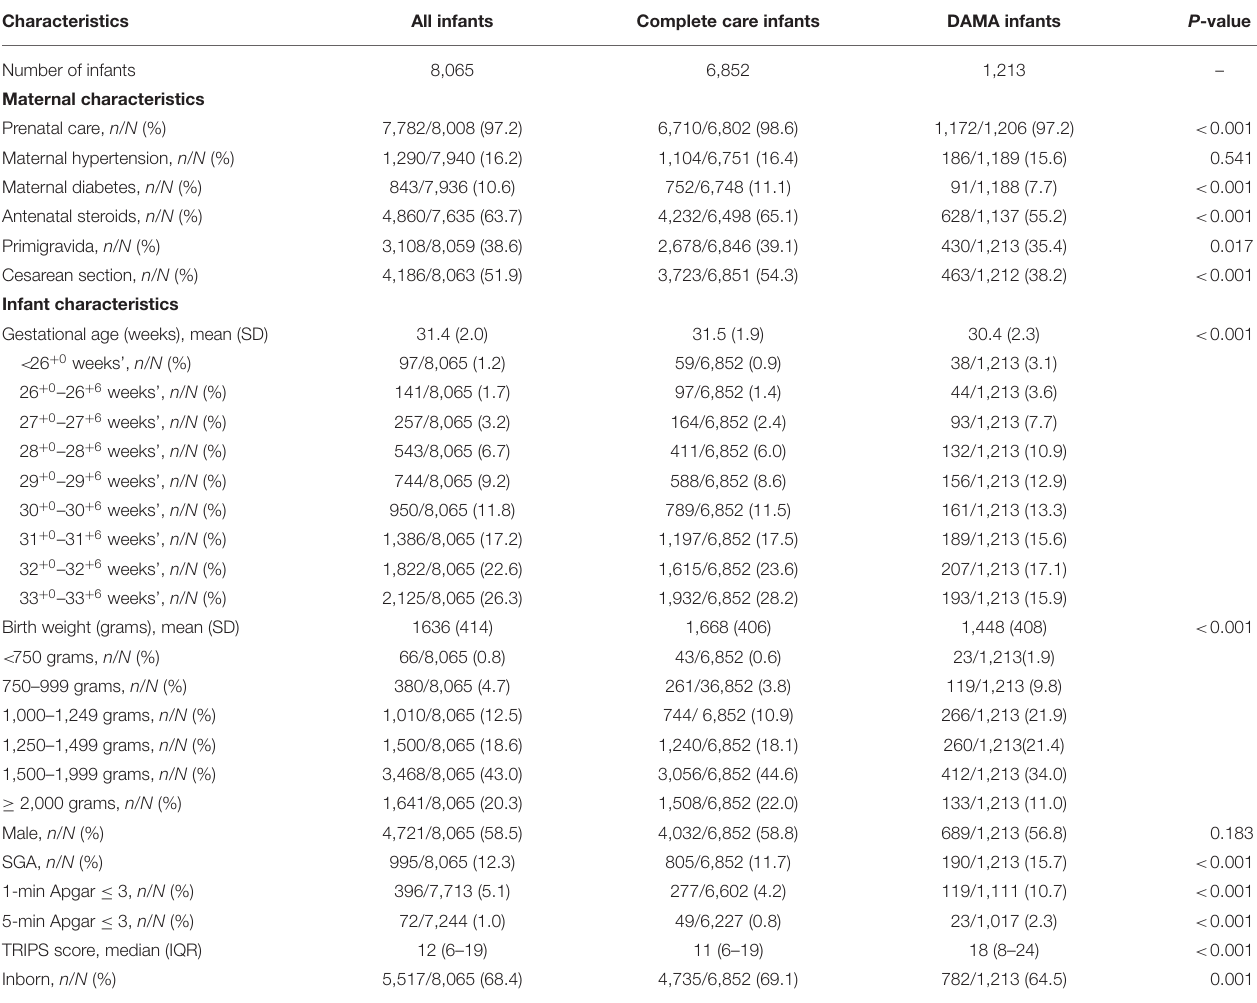
TABLE 1 | Characteristics of mothers and infants born at < 34 weeks’